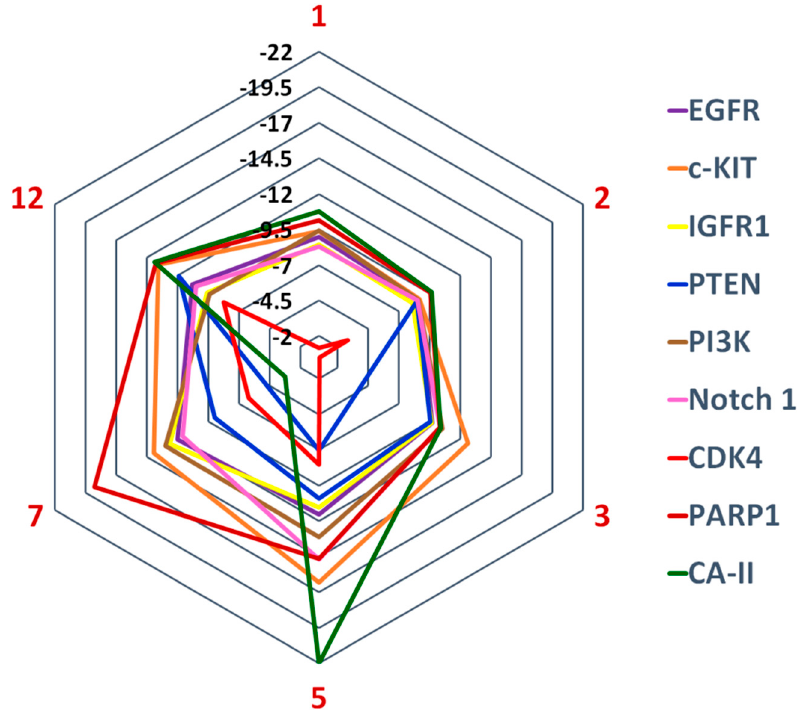
Figure 5. Graphical presentation of predicted cellular targets of Compounds 1 – 3 , 5 , 7 , and 12 based on docking scores.